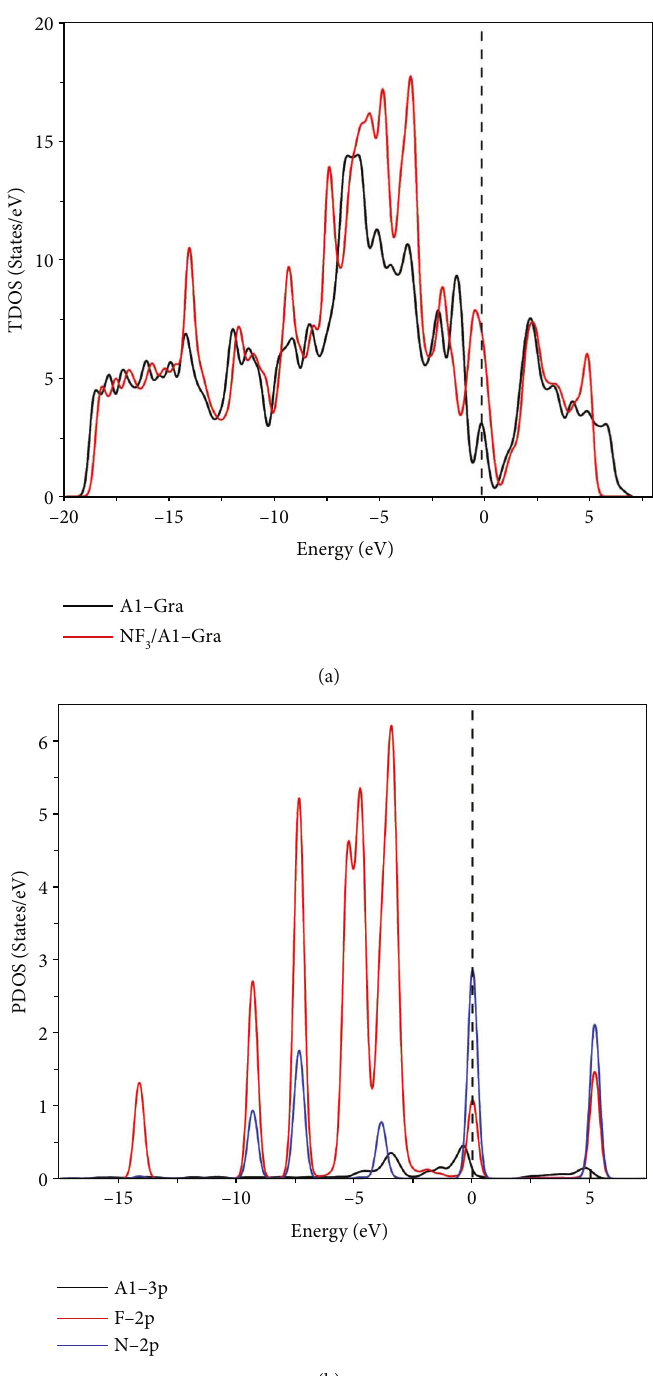
Figure 5: TDOS before and after NF adsorption and PDOS of the main interacting atoms ((a) TDOS; (b) 3